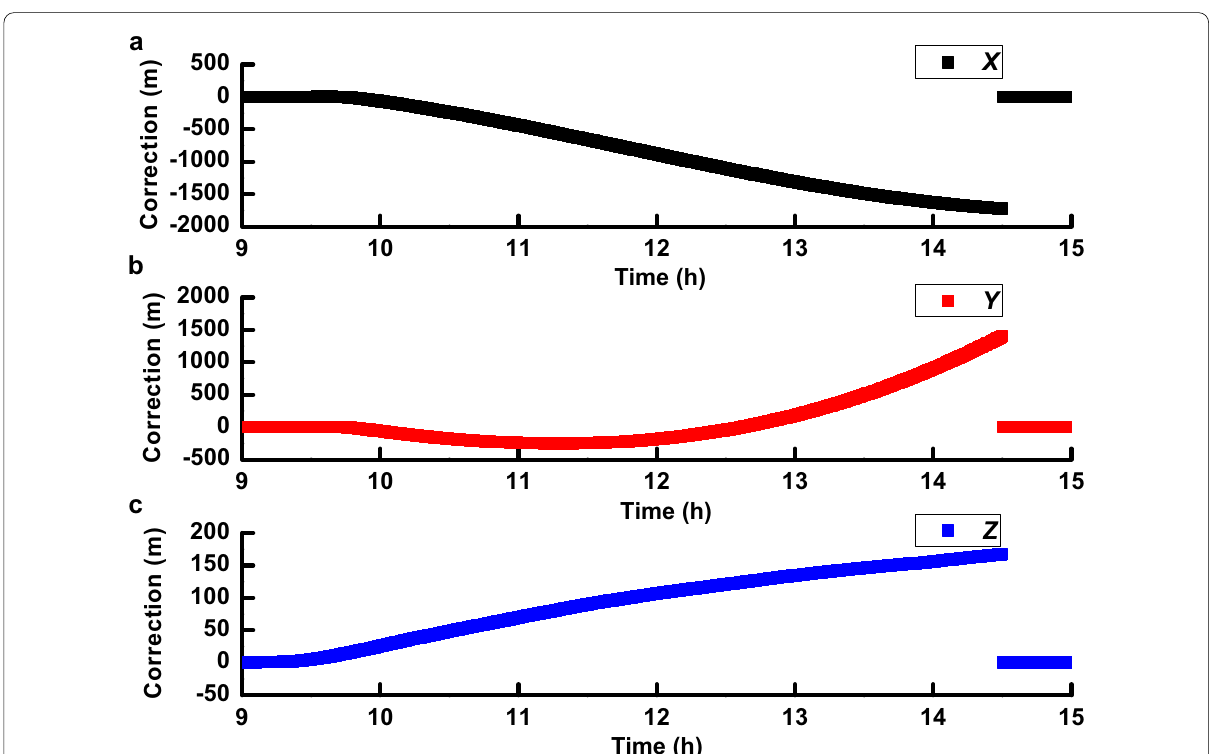
Fig. 3 Time series of the correction of the orbital error for BDS C01. The black a , red b , and green c colors represent the X , Y , and Z components in the WGS84,